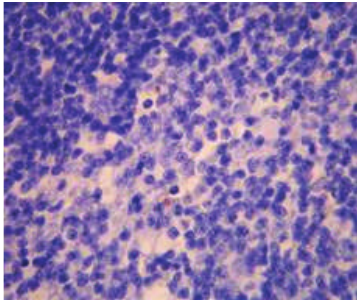
Figure 12: Treated group—28 d in OJ experiment thymus (several apoptoic cells), TUNEL × 400.